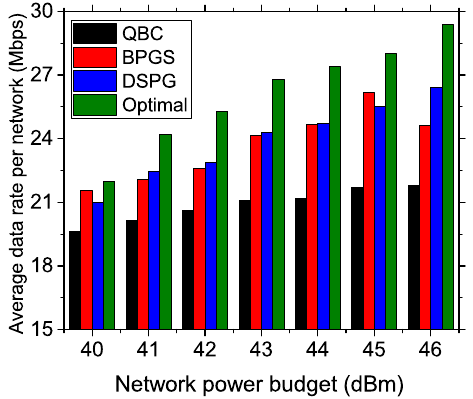
Figure 10. Average data rate vs. power budget of a